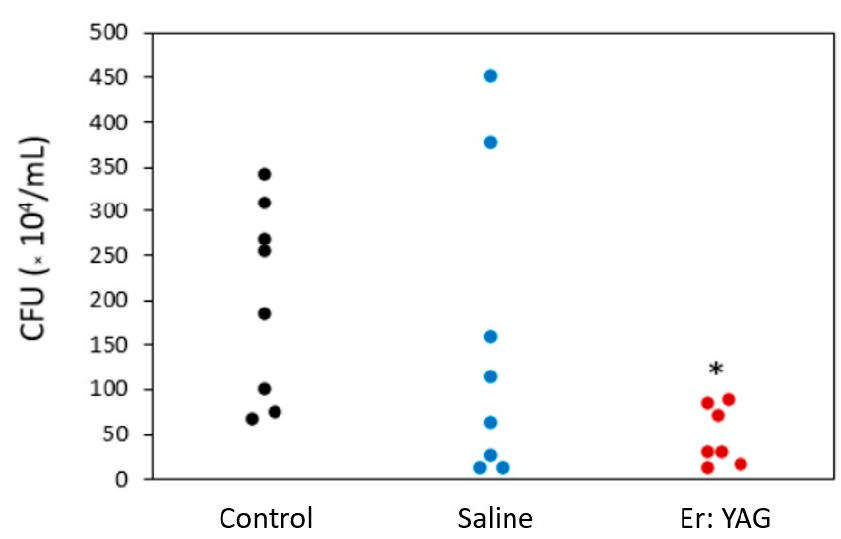
Figure 5. The number of colonies after treatment on E. faecalis -infected teeth with Er:YAG laser-Endo tip. Group 1: The CFU of E. faecalis in control infected samples without treatment (black). Group 7: The CFU of E. faecalis after saline irrigation (blue). Group 5: The CFU of E. faecalis after using an Er:YAG laser-Endo tip and saline irrigation (red). N = 8 in each group. * p < 0.01 for treated samples compared to control.